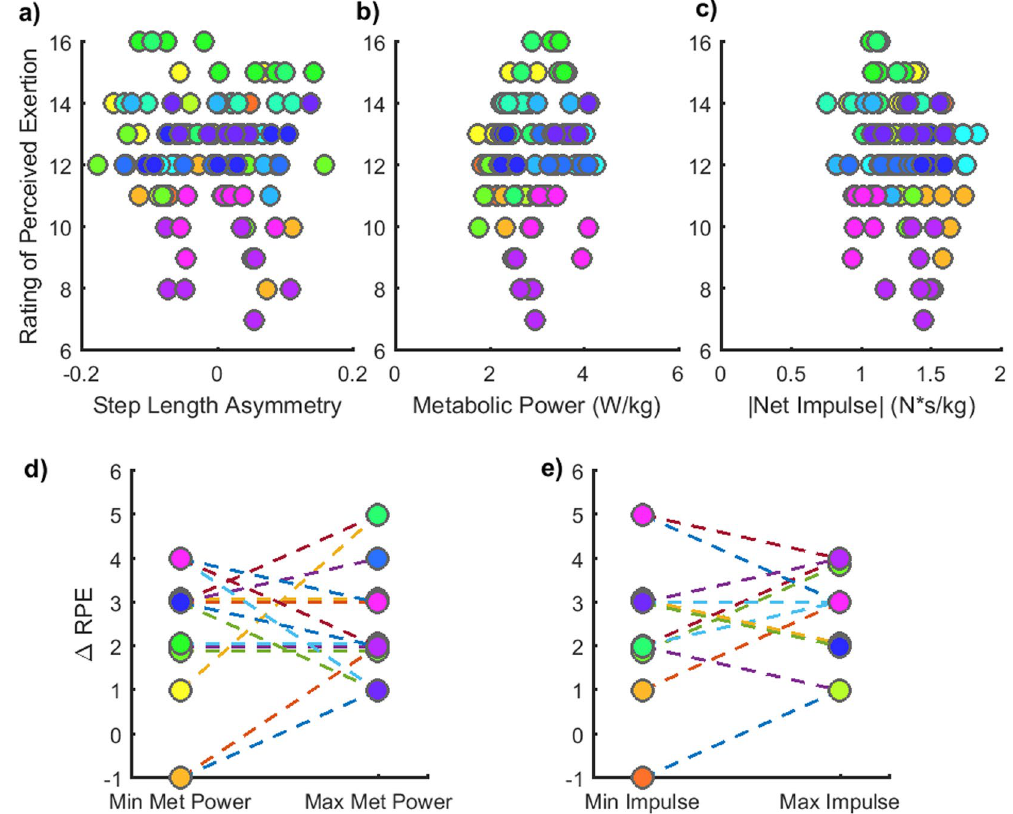
Figure 6. Ratings of perceived exertion (RPE). ( a ) RPE associated with each achieved step length asymmetry. ( b ) RPE as a function of the measured metabolic power. ( c ) RPE as a function of the measured net impulse. ( d ) RPE for the asymmetries associated with minimum (left) and maximum (right) metabolic power. Only five participants reported an increase in perceived exertion for the condition where the maximum metabolic cost was observed relative to the condition where the minimum cost was observed. ( d ) RPE for the asymmetries associated with minimum (left) and maximum (right) net impulse. No explicit awareness of the mechanical effort required was